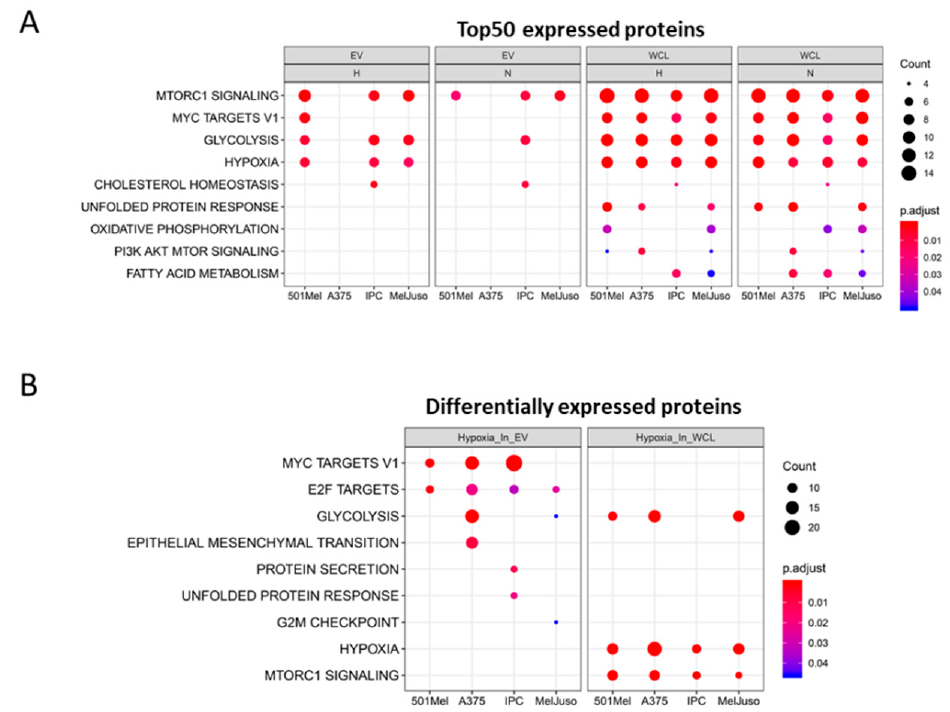
Figure 4. Graph showing enriched hallmarks ( A ) associated with the top 50 expressed proteins in nEVs, hEVs, normoxic or hypoxic WCL and ( B ) associated with differentially expressed proteins. Count is the number of genes identified per hallmark for the indicated compartment. Colour shows the adjusted p -value.